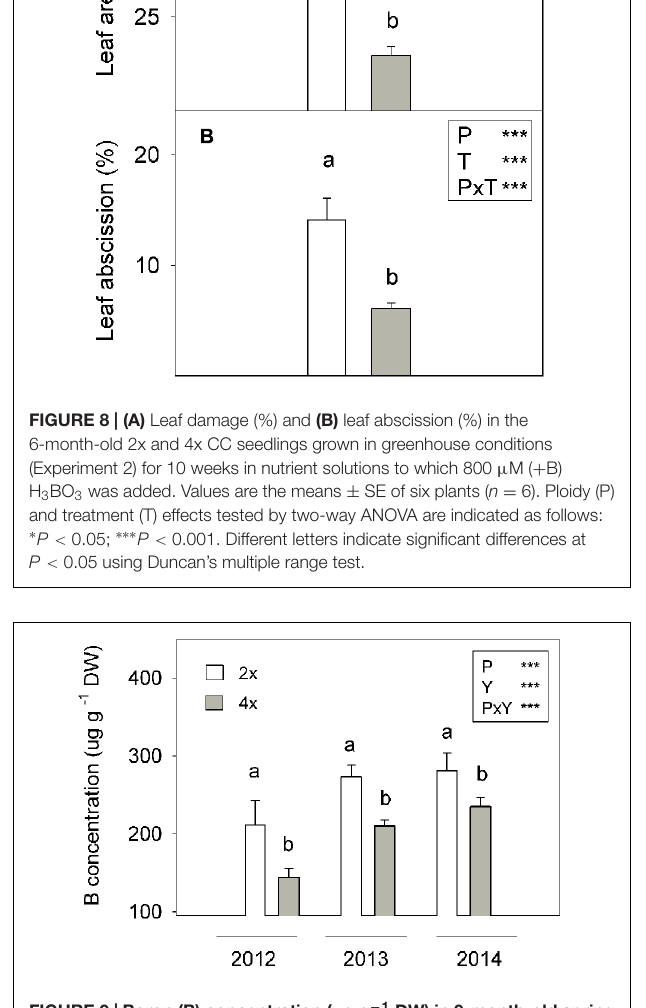
FIGURE 9 | Boron (B) concentration ( µ g g − 1 DW) in 9-month-old spring flush leaves of 5-year-old VL orange trees grafted onto the 2x and 4x CC rootstocks grown under field conditions (Experiment 3). Ploidy (P) and year (Y) effects tested by two-way ANOVA are indicated as ∗∗∗ P < 0.001. Values are the means ± SE of six leaf samples pooled from the four trees of each block. Different letters indicate significant differences at P < 0.05 using Duncan’s multiple range test.